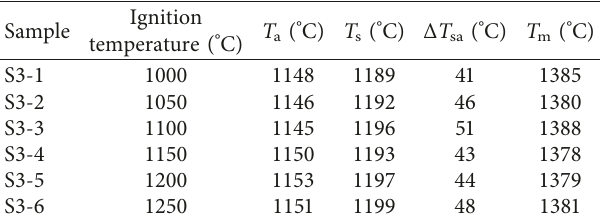
Table 12: Sintered ore softening performance in the sintering pot experiment at different ignition